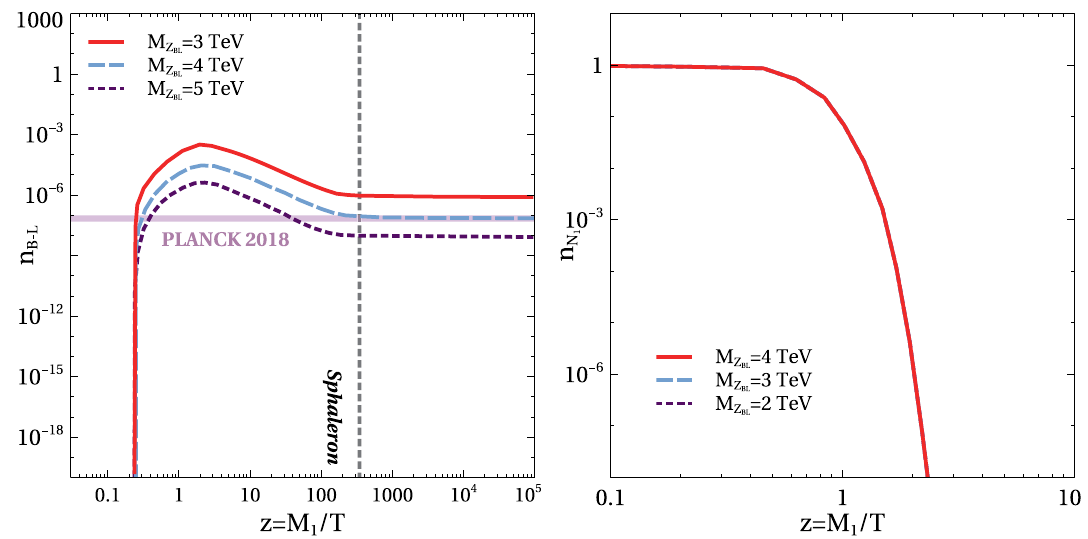
Fig. 4 Comoving density of B-L asymmetry (left panel) and comov- parameters used are M 1 = 45 TeV, M 2 = 450 TeV, m η = 5 TeV and M 1 g BL = 10 − 3 . The horizontal line in left panel plot denotes the required (right panel) with z = ing number density of N R for different 1 B − L asymmetry to generate for observed baryon asymmetry (Planck T M Z . The Yukawa couplings relevant for Leptogenesis are taken to be 2018) after sphaleron transition BL ( Y η ) α = 10 − 5 ( 1 + i ) and ( Y η ) α = 10 − 1 ( 1 . 1 − i ) . The other important 1 2